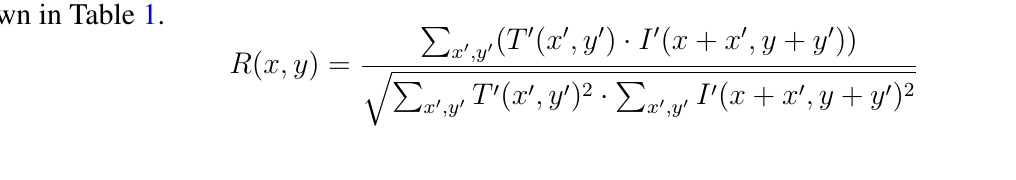
Figure 6. Matching results, ( a ) for circular signs, ( b ) for triangular signs.